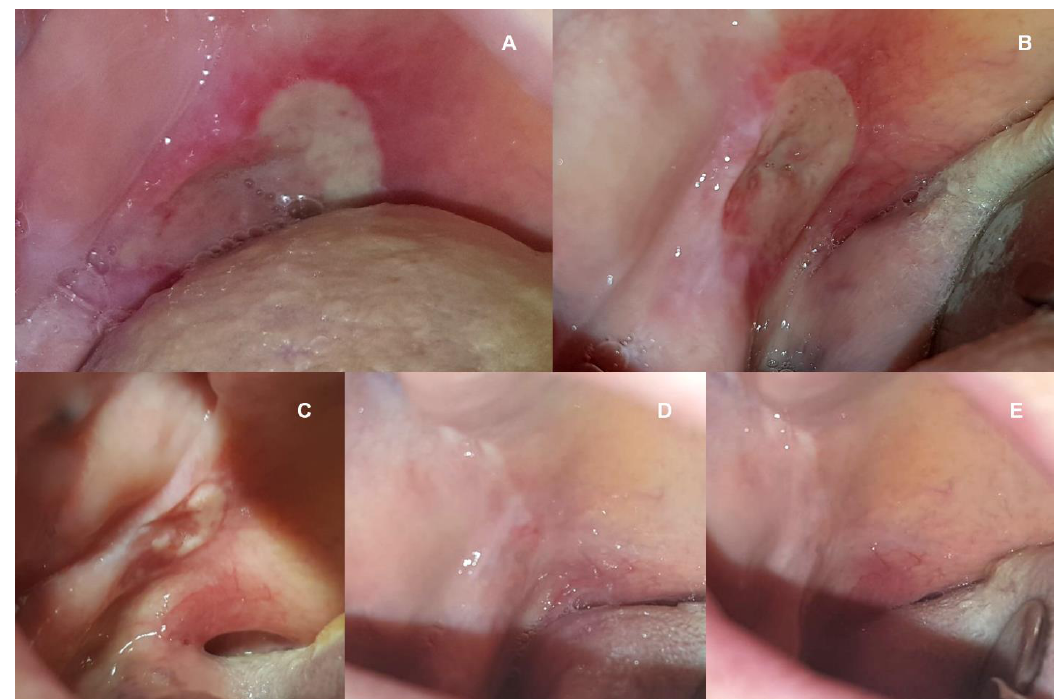
Figure 2. Views of the ulcer on the right pharyngeal arch just before the 1st PBM procedure ( A ), on the 4th day before the 2nd PBM procedure ( B ), on the 7th day before the 3rd PBM ( C ), on the 14th day before the 4th PBM ( D ), and on the 21st before the 7th and last PBM treatment ( E ).